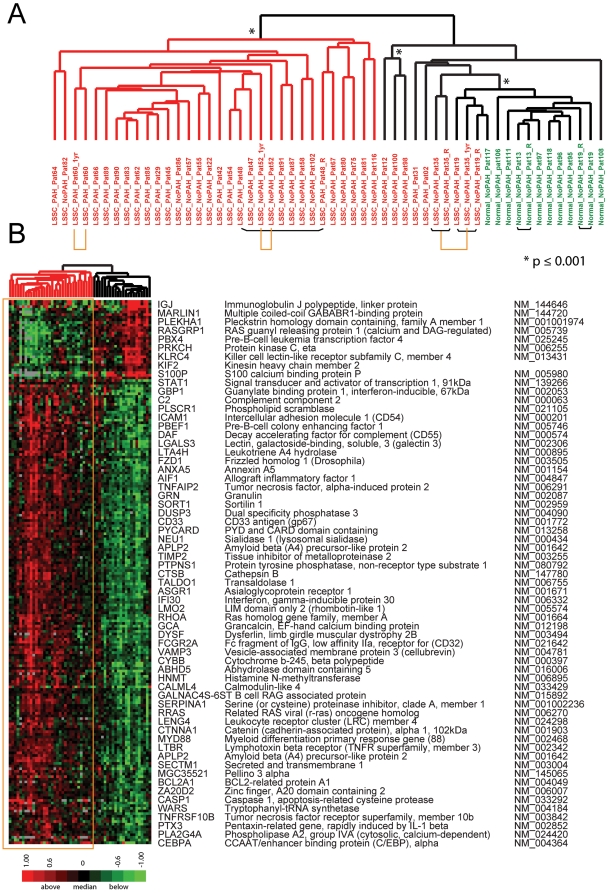
Gene expression differentiates lSSc PBMC samples from healthy controls.A. Clustering dendrogram using 206 probes that most differentiated lSSc (red identifiers) and healthy control samples (green identifiers; FDR cutoff<0.18%). Black bars beneath the sample identifiers connect technical replicates. Samples collected one year apart are indicated by yellow bars. Asterisks indicate statistically significant clustering determined by SigClust. The red dendrogram branch contains the majority of lSSc samples, and the black branch contains those lSSc samples most like healthy controls. B. Heat map showing expression of the 206 probes after 2-dimensional hierarchical clustering. Expression values above the mean for each probe are indicated in red and below the mean are indicated in green. The yellow box highlights the gene expression data for the dendrogram branch containing the majority of lSSc samples. A subset of genes is listed next to the heat map. The full figure with all probe names is available as Figure S1.